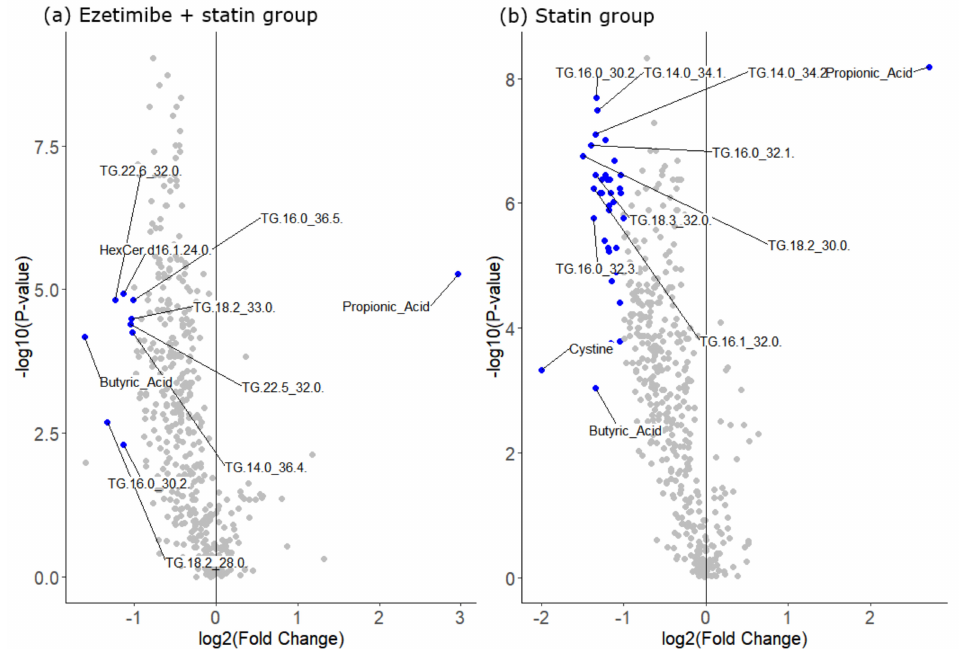
Figure 1. Fold-change analysis of metabolite concentrations between pre- and post-treatment by treatment groups, ( a ) ezetimibe + statin group and b statin monotherapy group. Significance of the fold change was defined by an FDR of < 0.05 and a fold change value of ≥ 2 (metabolites indicated by